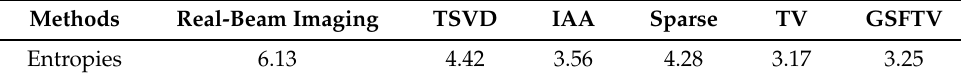
Table 5. Entropies of real data 2.